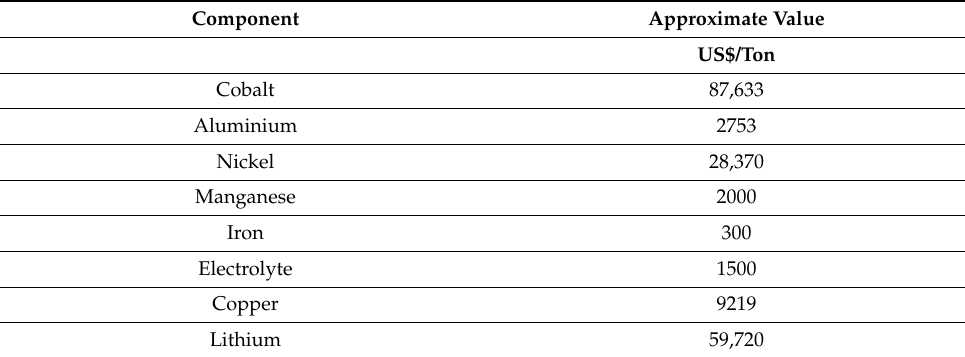
Table 1. Approximate value for main components in a typical Li-ion cell (April 2022) (data derived from ref.